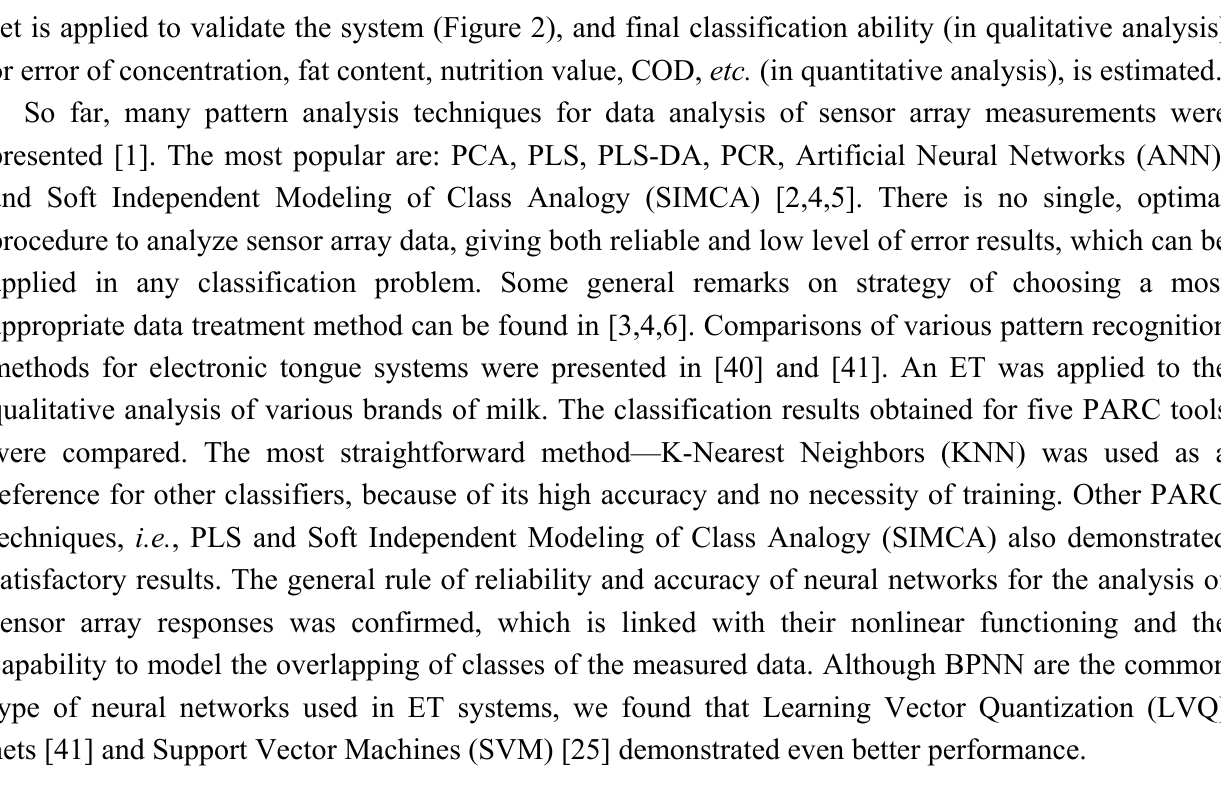
Figure 2. Data analysis procedures for potentiometric sensor